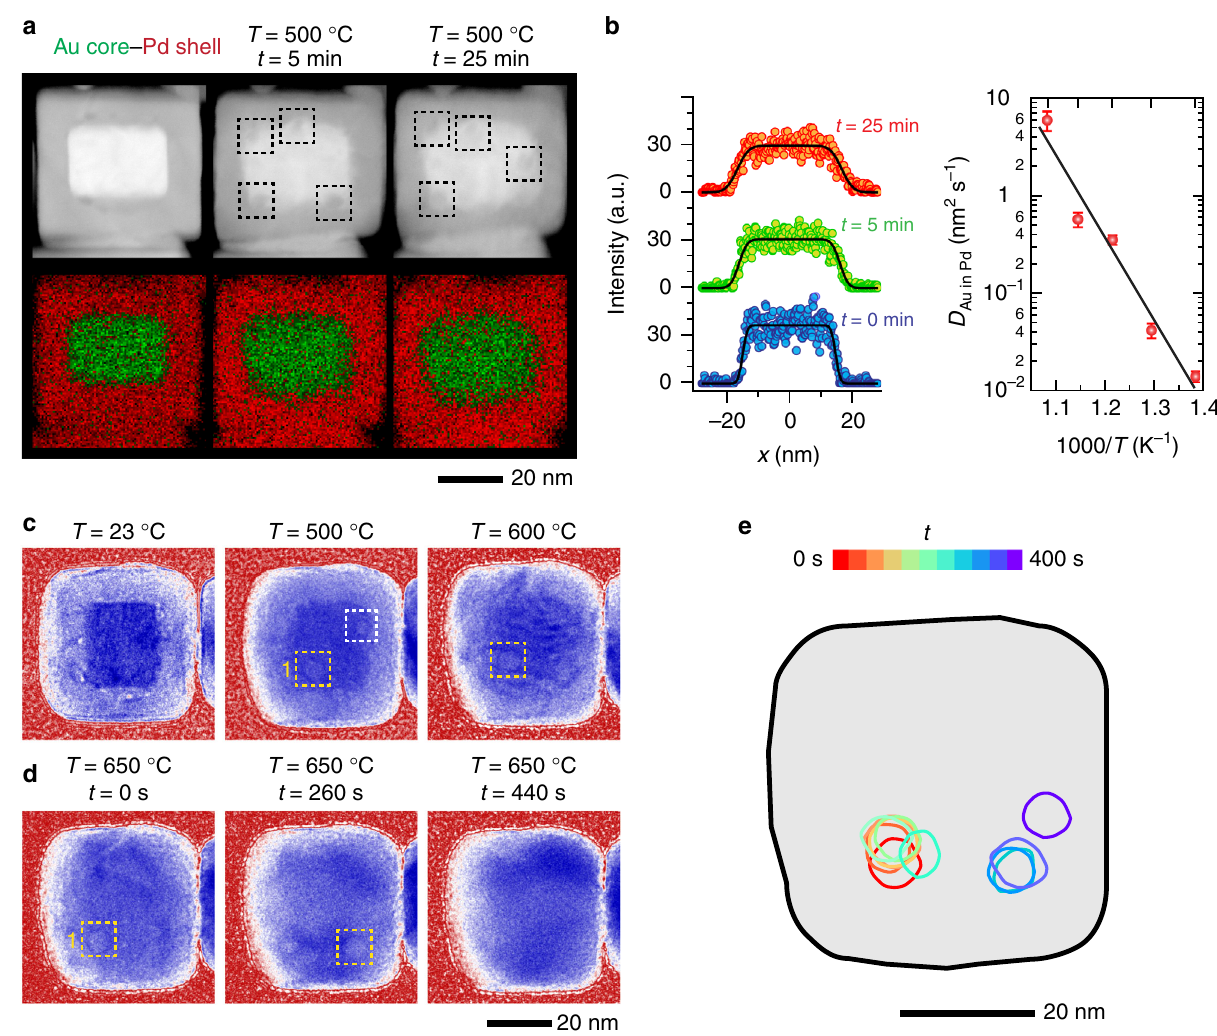
Fig. 1 Heating-induced changes in the morphology of Au core – Pd shell (Au – Pd) nanoparticles (NPs). a In situ scanning transmission electron microscopy (STEM) images of the same NP after heating at 500 °C for 5 and 25 min, and their corresponding energy-dispersive X-ray (EDX) elemental maps. In the STEM images, voids show up as round areas of dark contrast. Dashed boxes highlight some of the voids that appeared in the NP during the heating. b (Left) Diffusion pro fi les extracted from the EDX measurements presented in the panel ( a ) and their respective error-function fi ts (black curves). (Right) Diffusion coef fi cients of Au diffusing in Pd obtained from extended studies (Supplementary Fig. 2), where we followed the diffusion of Au in these NPs as a function of temperature and time. The error bars indicate the standard deviation in the diffusion coef fi cients obtained at each temperature. An Arrhenius fi t (black line) to the averaged diffusion coef fi cients gives the activation energy of E a = 1.6 ± 0.2 eV. c In situ transmission electron microscopy (TEM) image sequence of a NP during heating to 500 and 600 °C. In the TEM images, the voids (highlighted with dashed boxes) show up as dark rings with a light core. d Images recorded after increasing the temperature to 650 °C (Supplementary Movie 1). The time-stamps are pegged to time in the movie. The position of the void denoted as 1 is tracked over 400s in e . At t = 440 s, the void annihilated at the surface on the right of the